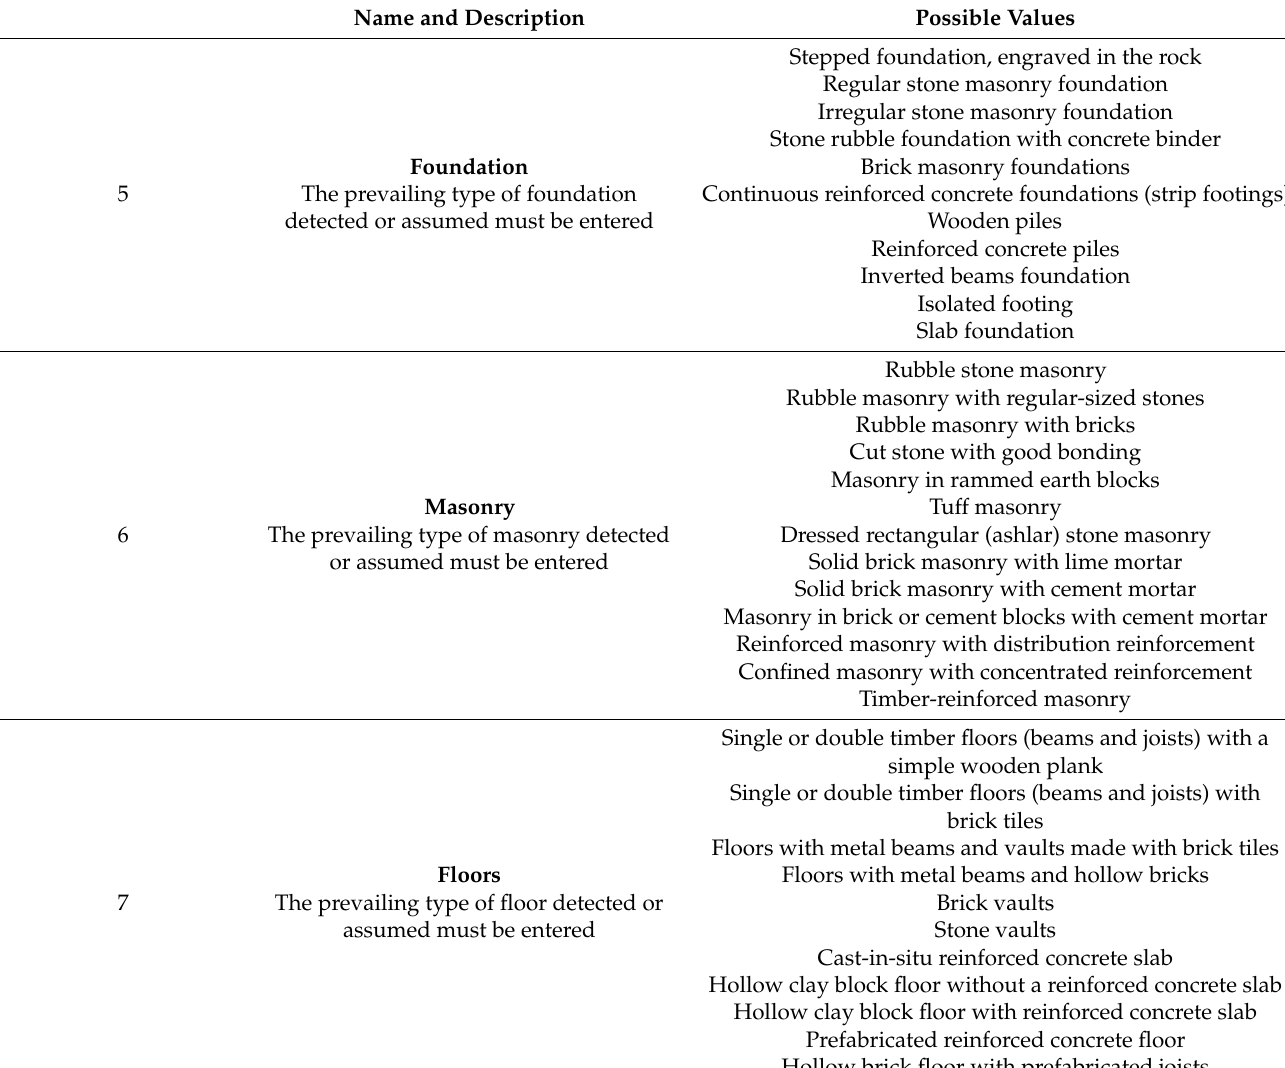
Table A2. Construction